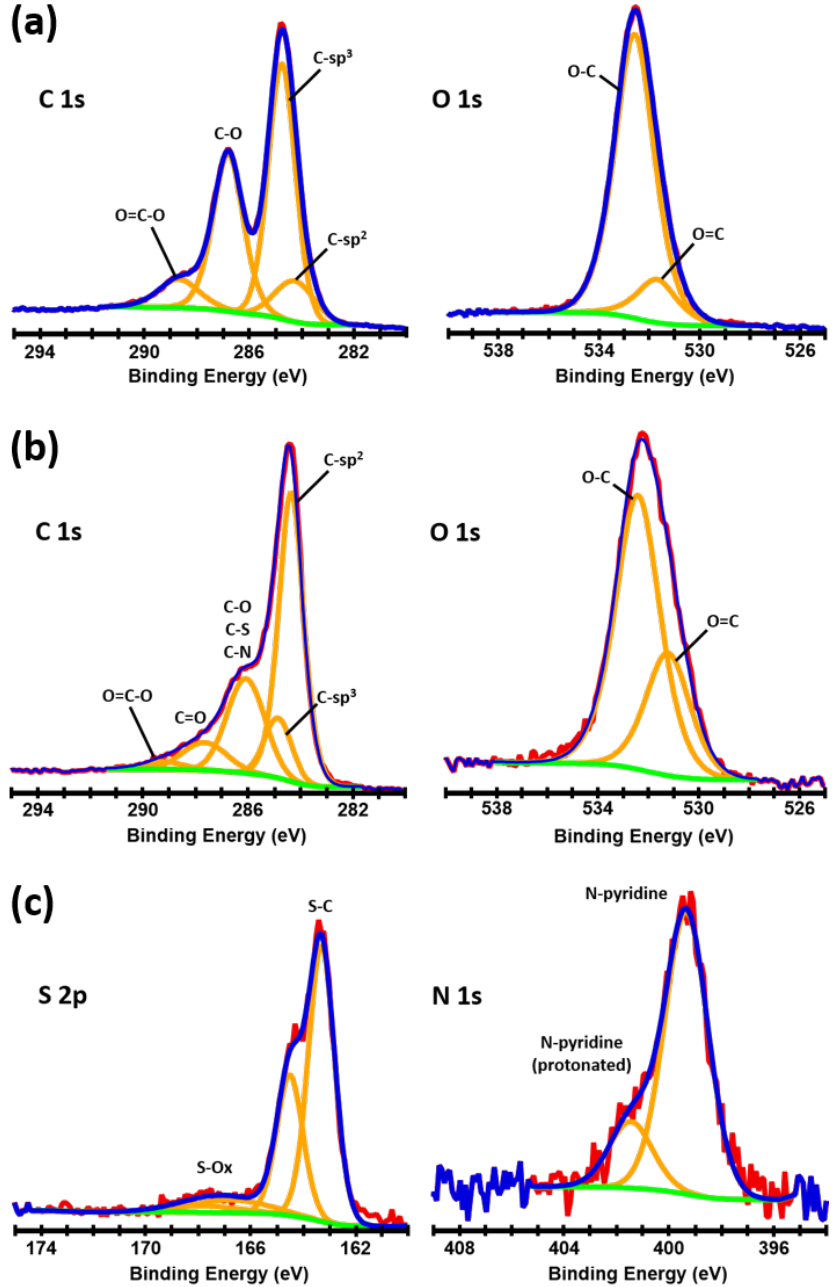
Figure 2. Core level spectra fitting analysis of the ( a ) GO and ( b , c ) rGO – SH-2 samples.